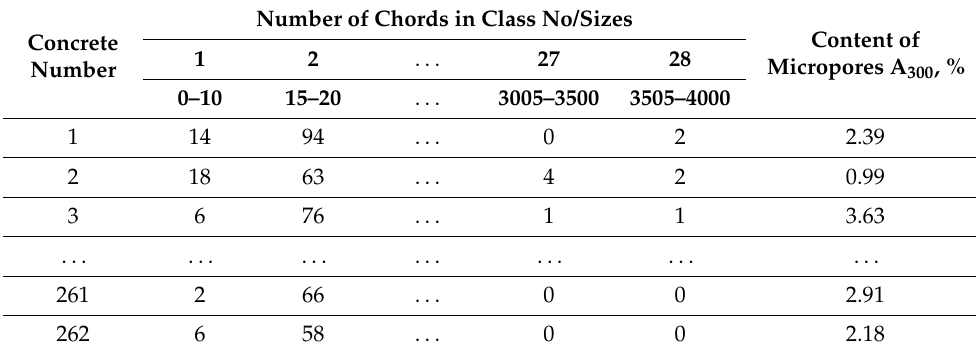
Stage 1 : Analysis of the dataset including all 28 chord classes The dataset for the calculations is shown schematically in Table 2. Table 2. Schematic of the table adopted for multiple regression calculations.